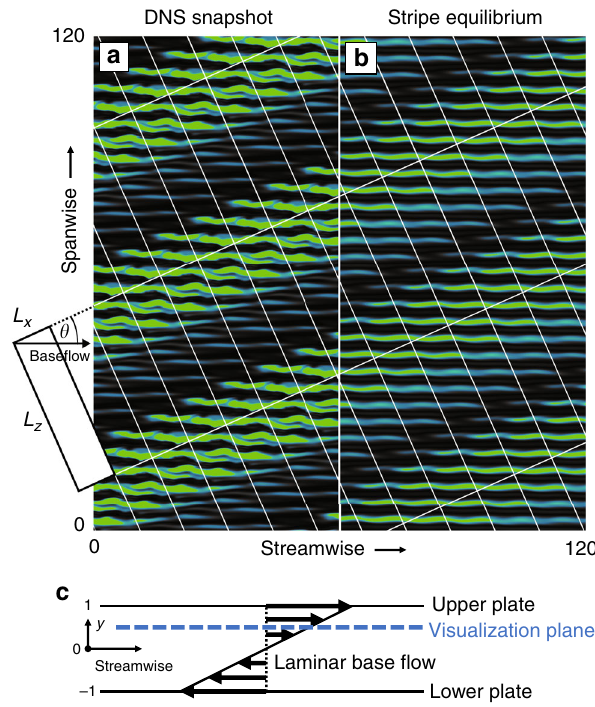
Fig. 1 Equilibrium solution underlies turbulent-laminar stripes. a The self- organized pattern of oblique turbulent-laminar stripes is observed in direct numerical simulations of plane Couette fl ow at Re = 350. Following ref. 7 a tilted x - z -periodic domain outlined on the left side with ( θ , L x , L z ) = (24°, 10, 40) is used for computations. b The observed stripe pattern is captured by an exact invariant equilibrium solution of the fully nonlinear 3D Navier – Stokes equations. The contours are turbulent kinetic energy saturating at u 2 = 0.25 (green), where u is the velocity fl uctuation fi eld around the laminar base fl ow ( c ). The plane of visualization is at 3/4